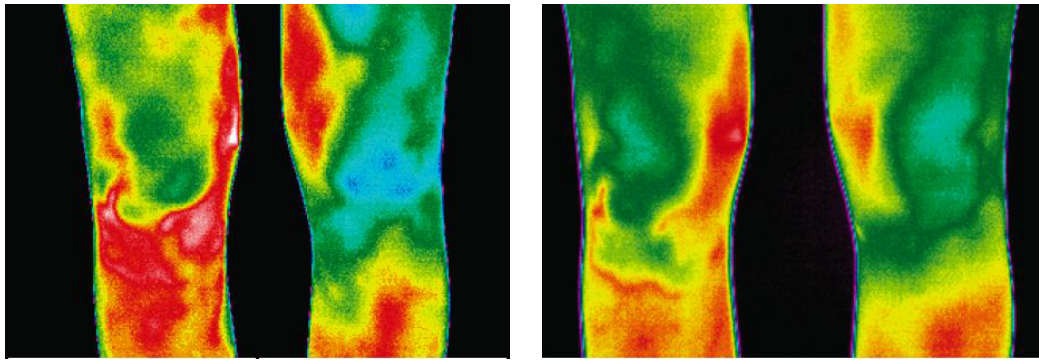
Figure 5. Infrared image of the anterior aspect of the knees (ACL rupture in the right knee).